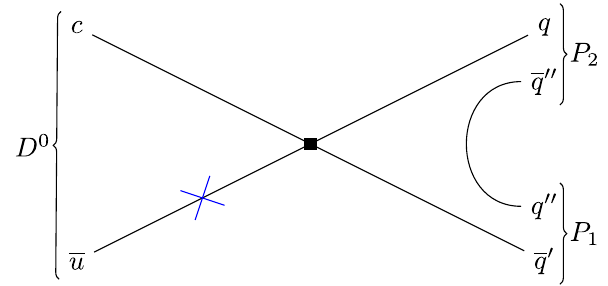
Fig. 1 The weak annihilation diagram for D → P 1 P 2 γ . The blue cross indicates the dominant photon emission from the light quark of the D meson. Photon emission from the other quark lines is suppressed by powers of λ QCD / m c or α s